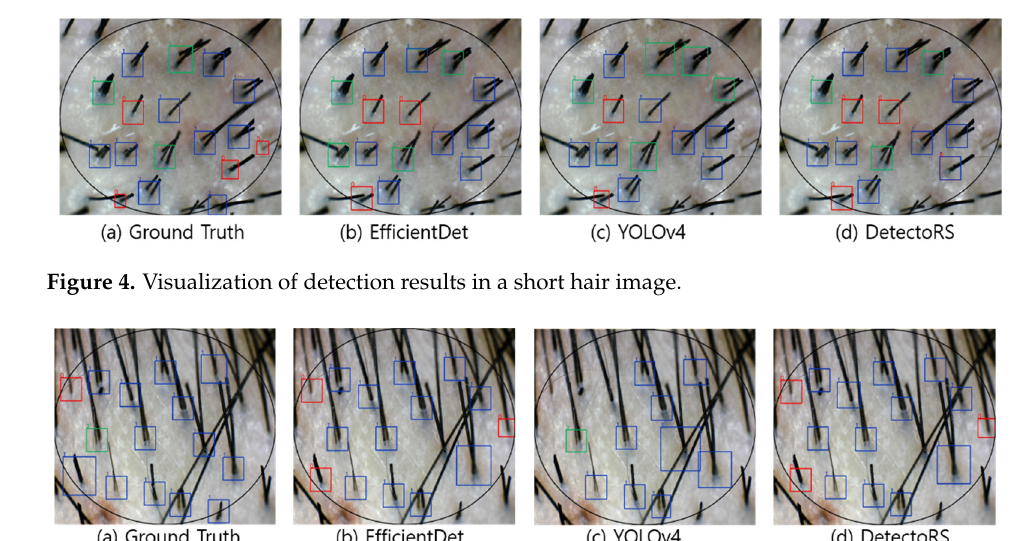
Figure 3. Performance comparison by class.